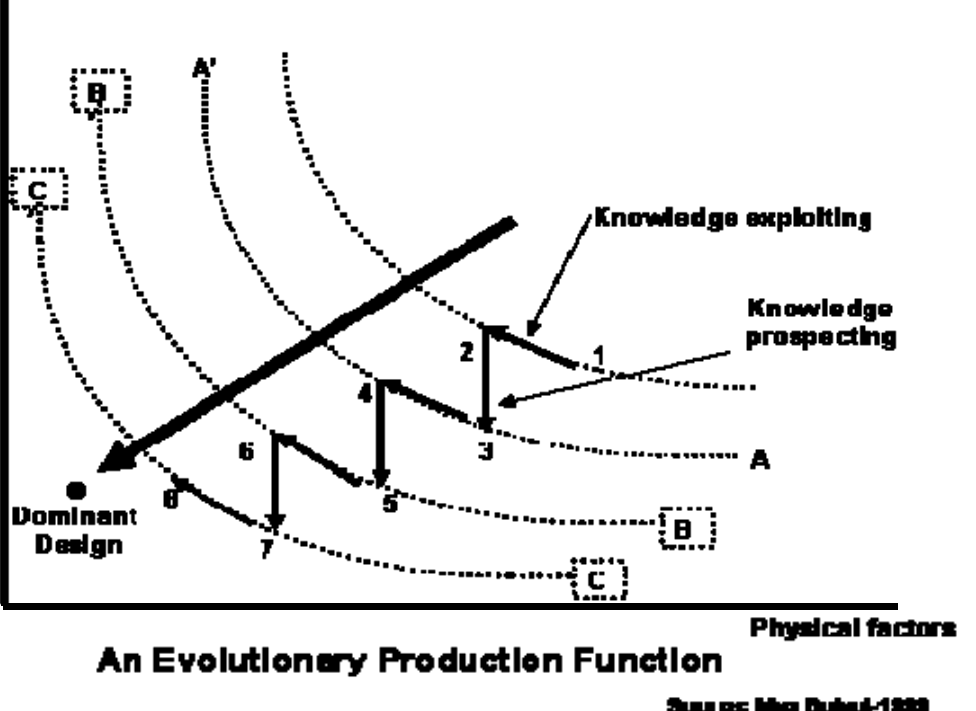
Figure 4: Boisot’s evolutionary production function showing movement towards dominant design It is proposed that based on above argumentation, macro e-business systems like SCM, ERP, and CRM are moving towards dominant designs.